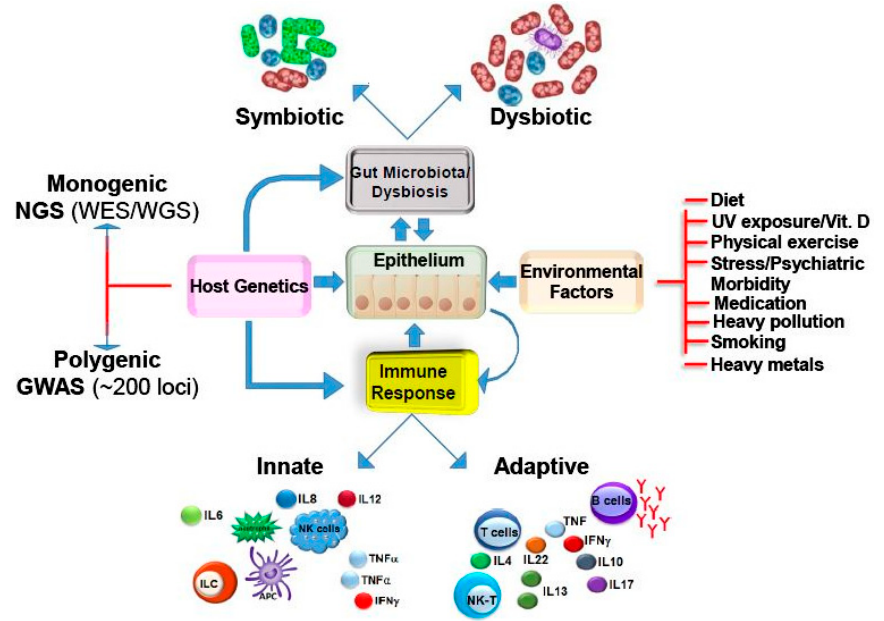
Figure 1. The cross-talk amongst the intestinal epithelium, gut microbiota, environmental factors and immune response along with host genetics dictates IBD pathogenesis. The intestinal epithelium is at the crossroad of IBD pathogenesis by coordinating the link amongst the factors implicated in the disease onset such as microbial flora, environmental factors, or the host immune response by directly interacting with those factors. Both the innate and adaptive immune responses show a disturbance in homeostasis. Flares of diseases have been associated with environmental factors, such as use of antibiotics and NSAIDs, stress and smoking. These factors or infections are thought to alter the barrier function of the epithelium, leading to loss of immune tolerance to intestinal antigens. The role of genetic factors is indicated by familial clustering of cases and higher incidence in monozygotic twins. Host genetics can itself influence the gut microbial composition or immune response to affect the disease pathogenesis.